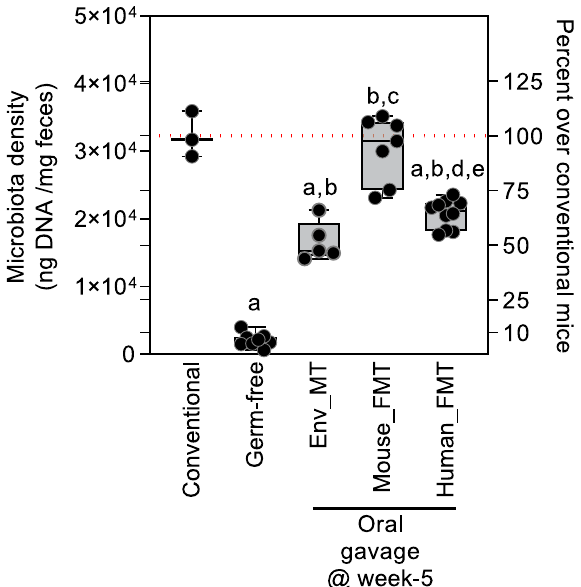
Figure 2. Variation in gut microbiota density in gut-colonized mice. Total fecal DNA levels per mg wet weight of feces. Ordinary one-way ANOVA was performed for comparisons between the samples. a p < 0.0001 versus Conventional, b p < 0.0001 versus Germ-free, c p < 0.0001 versus Env MT, d p < 0.05 versus Env MT and e p < 0.0001 versus Mouse